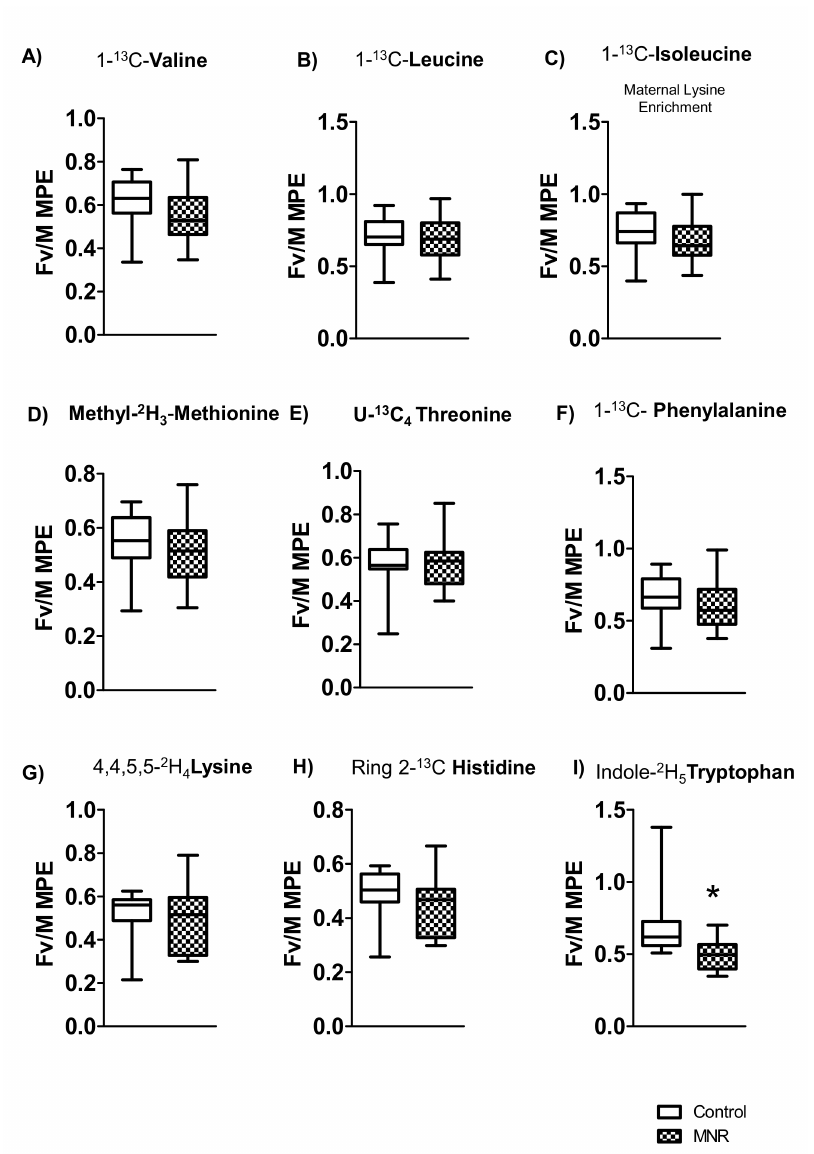
Figure 3. In vivo transplacental transport of (1- 13 C) valine, (1- 13 C) leucine, (1- 13 C) isoleucine, [Methyl- 2 H 13 C 13 C] phenylalanine, [4,4,5,5- 2 H 13 C] histi- 3 ] methionine, [U- 4 ] threonine, [1- 4 ] lysine, [Ring 2- dine, and [Indole- 2 H 5 ] tryptophan. Fetal vein/maternal artery (Fv/M) mole percent excess (MPE) ratios of stable isotope-labeled nine EAAs after intravenous infusion of a mixture of labeled EAAs to the control and MNR pregnant baboon at cesarean section (GD 140). Umbilical vein blood samples were obtained 5 min after the completion of EAA infusion. Fv/M MPE ratios of valine, leucine, isoleucine, methionine, threonine, phenylalanine, lysine, histidine, tryptophan in control (n = 8) and MNR (n = 11) baboons at GD 140. Medians ± IQR, * p < 0.05. KS normality test p value: (1- 13 C) valine (Control, p > 0.10; MNR, p > 0.10; passed normality), (1- 13 C) leucine (Control, p > 0.10;